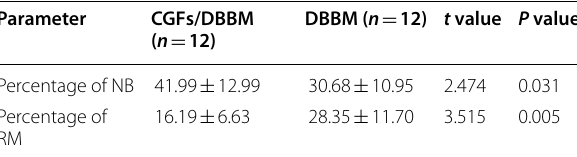
Table 3 Comparison of the percentages of NB and RM for the CGFs/DBBM and DBBM groups (%, Mean